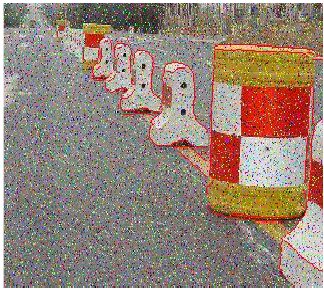
Figure 7 Edge detection in t αβ